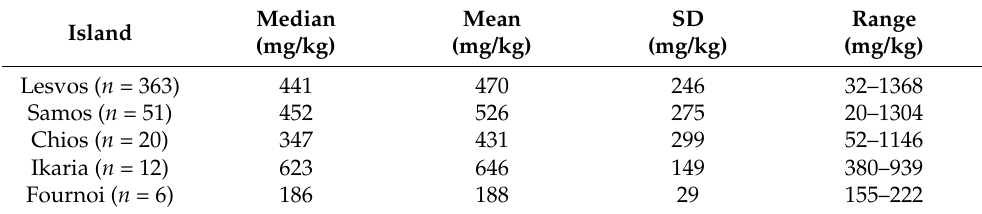
Figure 2. Comparison of the phenolic content (mg/kg) of EVOOs between the islands (Lesvos, Samos, Chios, Ikaria, and Fournoi) of the North Aegean Region. Table 5. Statistical parameters for the phenolic content of EVOOs for each island.